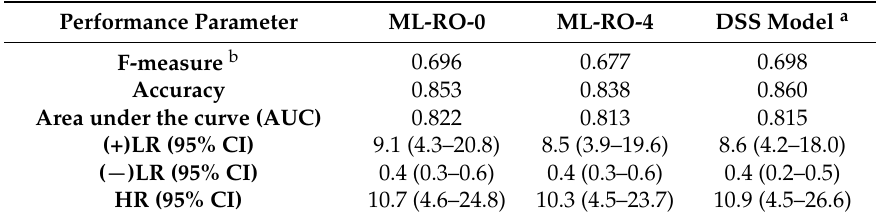
Table 3. Analytical performance of machine learning with random optimization in the testing